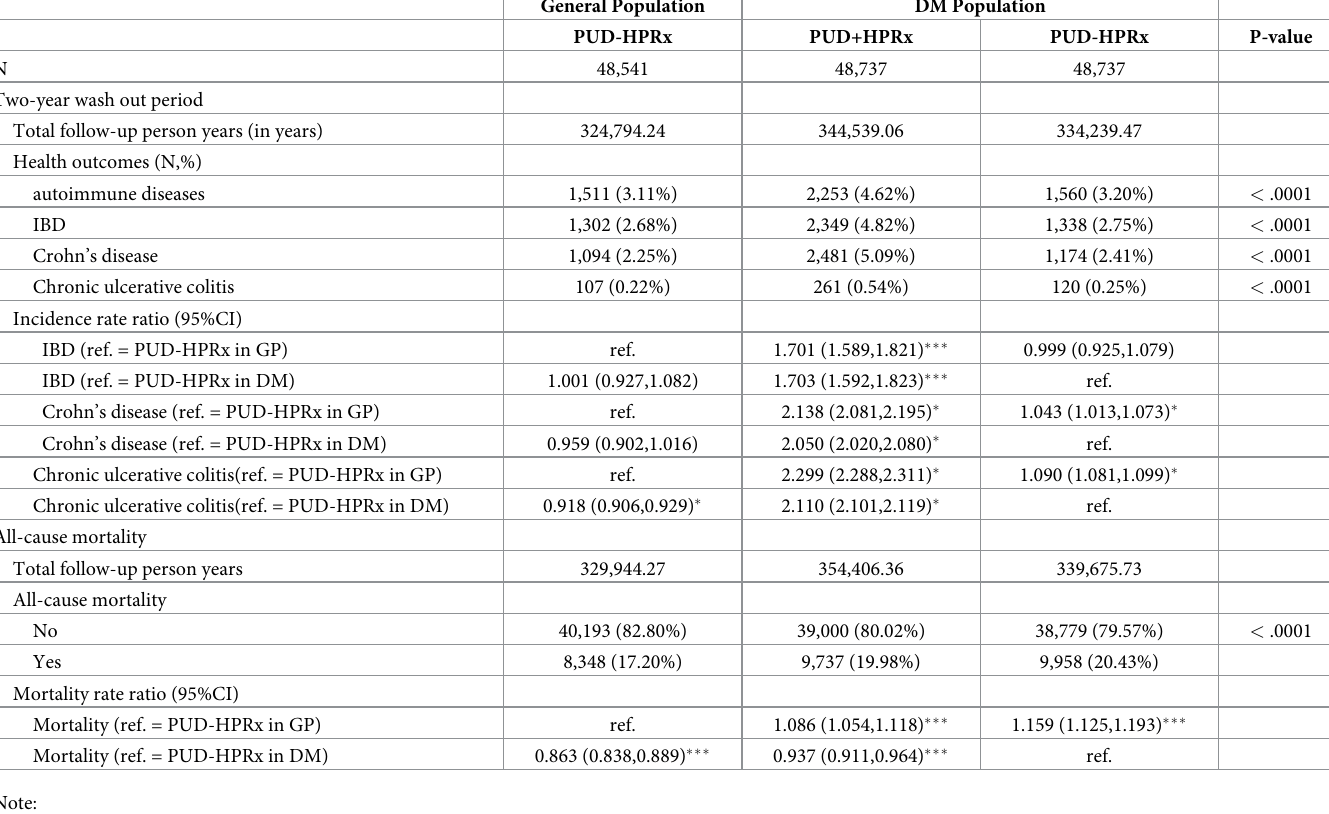
Table 2. Autoimmune disease and inflammatory bowel disease outcomes in the matched cohorts. General Population DM